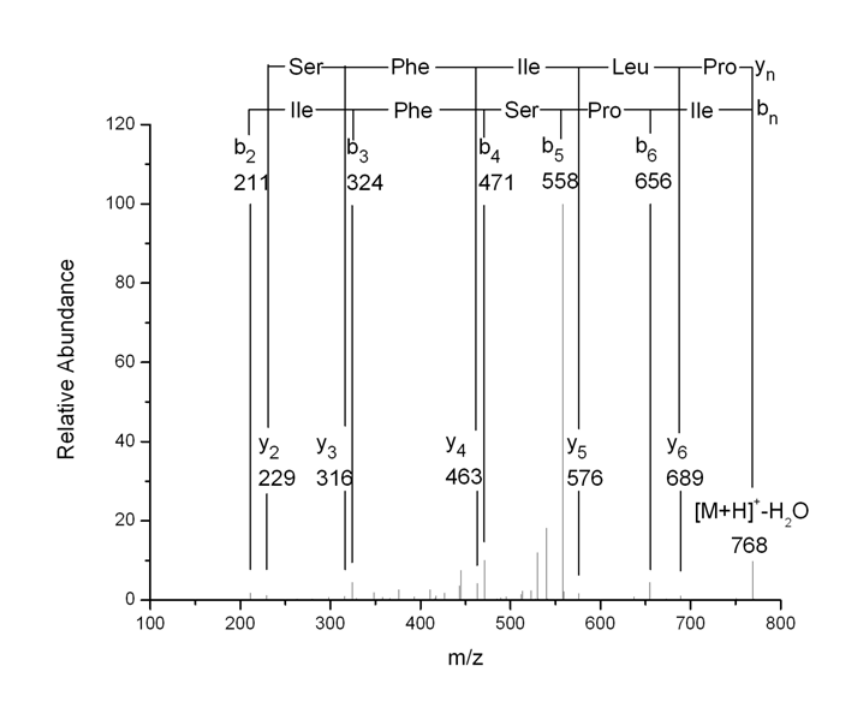
Fig. 7 CAD spectrum of crude heptapeptide 2 from [M+H] + ion of m/z 786.5. The x, z, a, and c ions were not labeled for